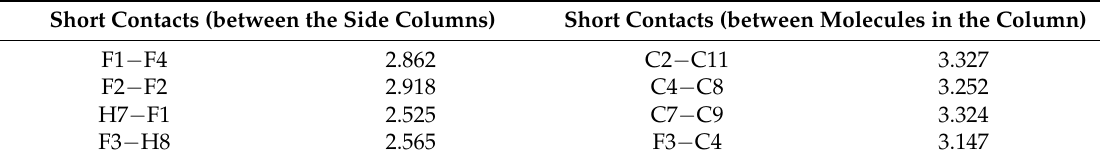
Table 1. Selected intermolecular short contacts (Å) of the molecule 4a .